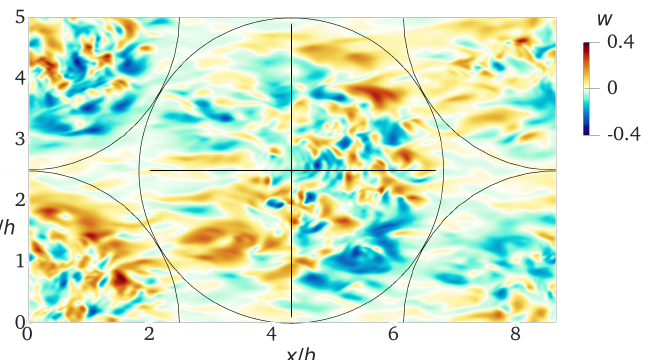
Figure 5. Instantaneous spanwise velocity component w on a wall-parallel plane at y + = 1.3 from the flat part of the wall. Lengths and velocities are made dimensionless with h and U b . The velocity field is computed by DNS for a circular dimple, which actually yields a drag